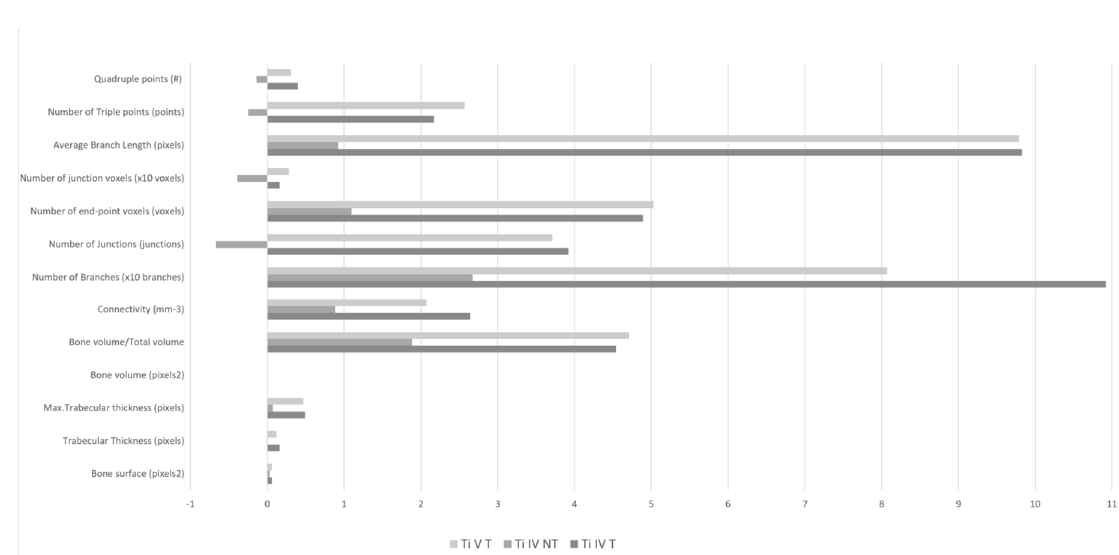
Figure 4. Comparison of bone density (BoneJ).